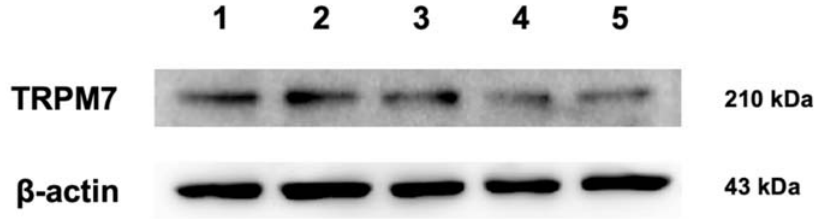
Figure 3. Protein expression of TRPM7 in the five (1–5) canine mammary gland tissues revealed by Western blotting. The immunoreactive bands of approximately 210 kDa were confirmed in all samples. β‐ Actin (43 kDa) was used as the loading control.